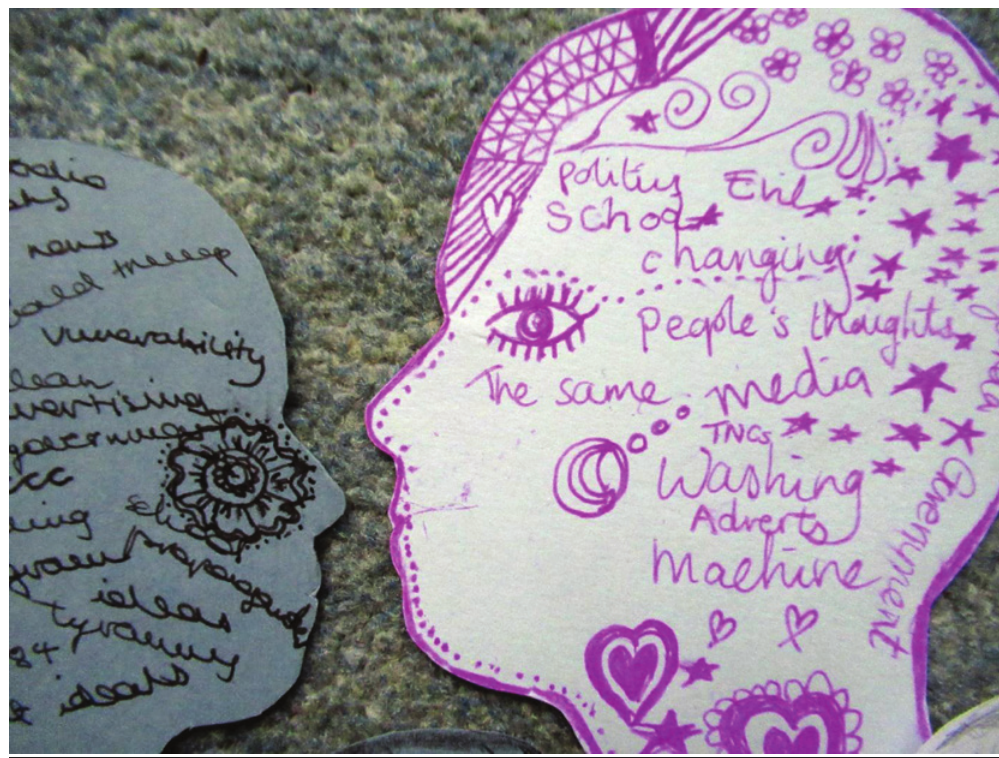
Figure 2: Graffiti heads (photograph: Lizzie